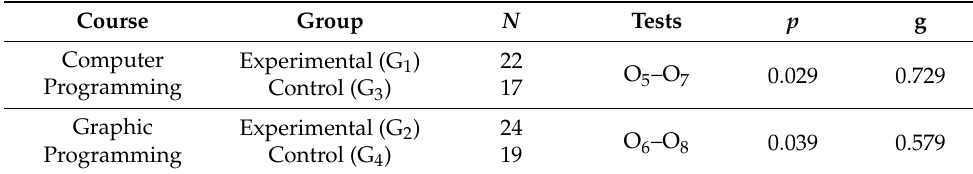
Table 14. Mann–Whitney U Test for post-tests.